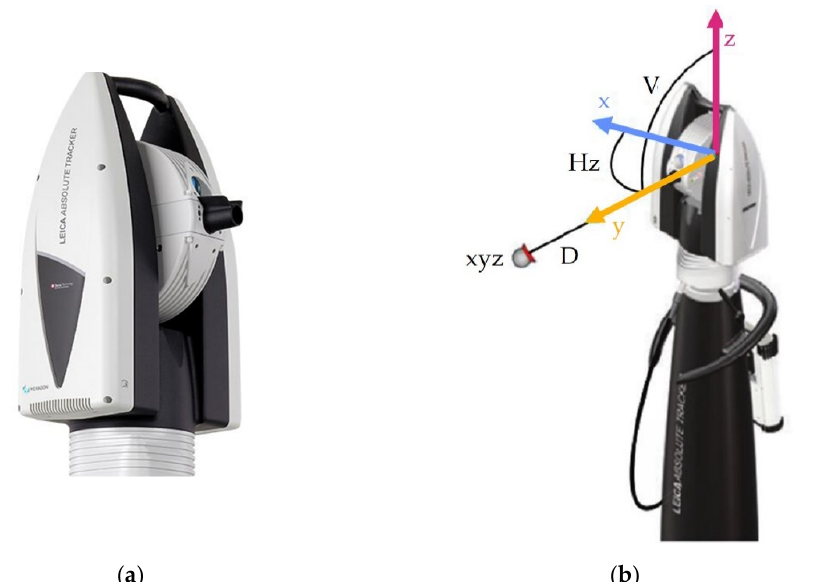
Figure 1. Laser tracker: ( a ) Leica AT 960 head; ( b ) the concept of measuring with a laser tracker. This tracker allows for accurate measurement of the position of a selected point in three directions simultaneously. In the case of measurements on a robot, it is necessary to attach a mirror reflecting the laser beam. Measurement with a laser tracker is classified as coordinate-measuring systems. The principle of operation of trackers is based on the com- bination of two techniques, namely, laser interferometry, which allows measuring the dis- tance of the target from the measuring head, and measuring the angles of setting two ro- tational axes: azimuth and height (Figure 1b). In the case of laser trackers, mirrors are used as the measuring target to reflect the laser beam generated by the device. Most often these are Spherically Mounted Retrore- flectors (SMR). The mirrors in the retroreflector are mounted precisely at the right angle to each other in such a way that their point of contact (apex) is exactly in the center of the SMR (Figure 2). This makes it possible to precisely determine the coordinates of the posi- tion of the retroreflector in three-dimensional space. Figure 2. Construction of a laser tracker retroreflector. Laser trackers in robotic measurements are used for a variety of applications. Theis- sen, Laspas, and Archenti [12] present an innovative methodology for measuring the sus- ceptibility of articulated serial robots, and a laser tracker is used to measure the response of the system.